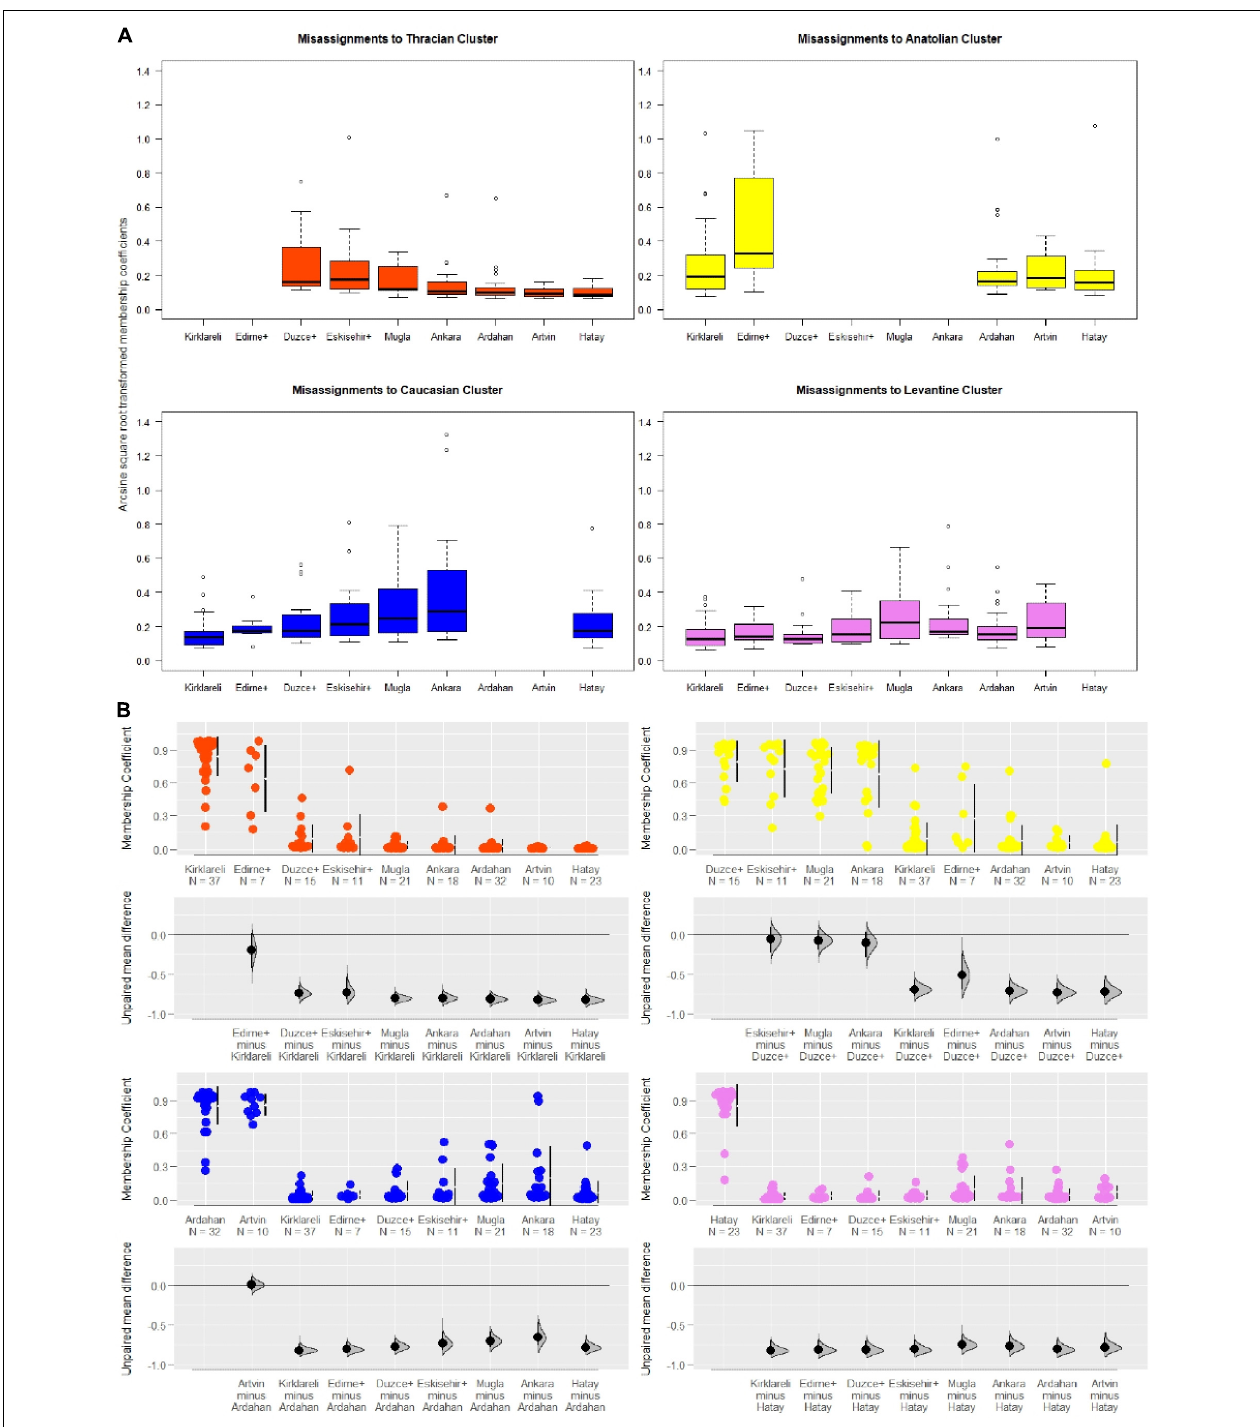
FIGURE 7 | Patterns of gene flow between populations. (A) Boxplot displays of arcsine square-root transformed membership coefficients mis-assigned to each cluster (12 significant differences out of a total of 80 comparisons are provided in the Supplementary Material ). (B) Scatter plots with estimations of mean differences based on raw individual membership coefficients to each cluster (orange: Thracian, yellow: Anatolian, blue: Caucasian, violet: Levantine clusters) contrasted against Kırklareli, Düzce +, Ardahan, and Hatay populations representative of four subspecies. Bars right to the data points refer to the 25 and 75% quartiles and the gap between them is the median